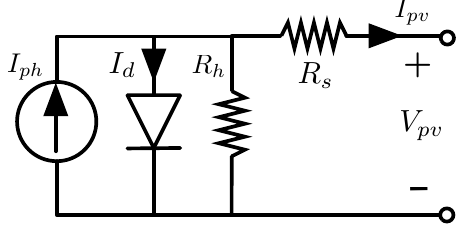
Figure 1. Equivalent circuit of the single-diode